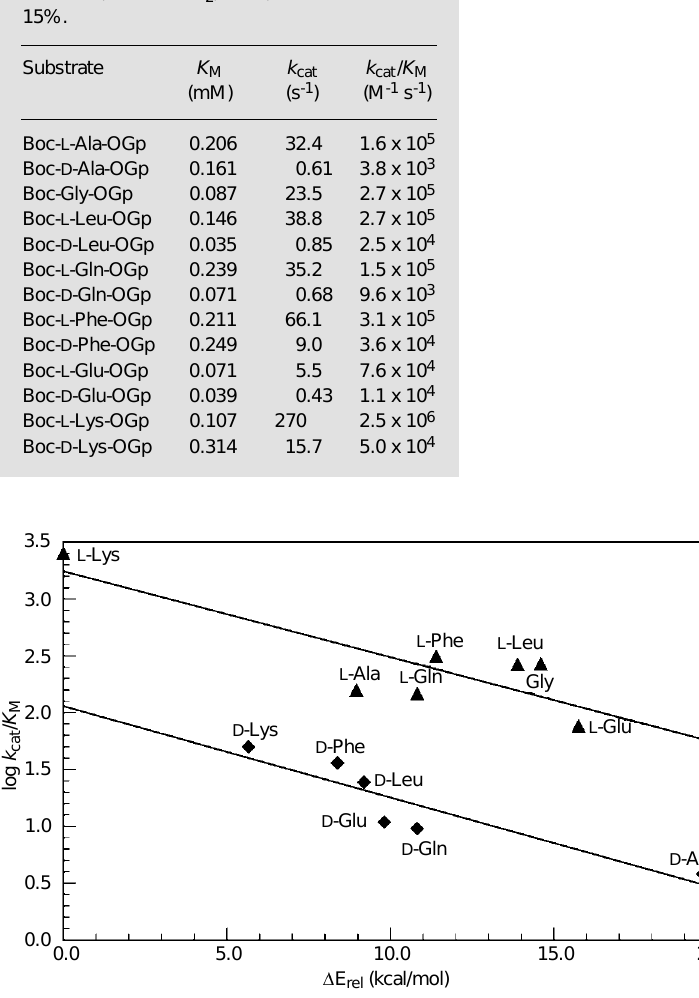
Table 1 - Steady-state kinetic parameters for the hydrolysis of Boc-Xaa-OGp by trypsin (25).